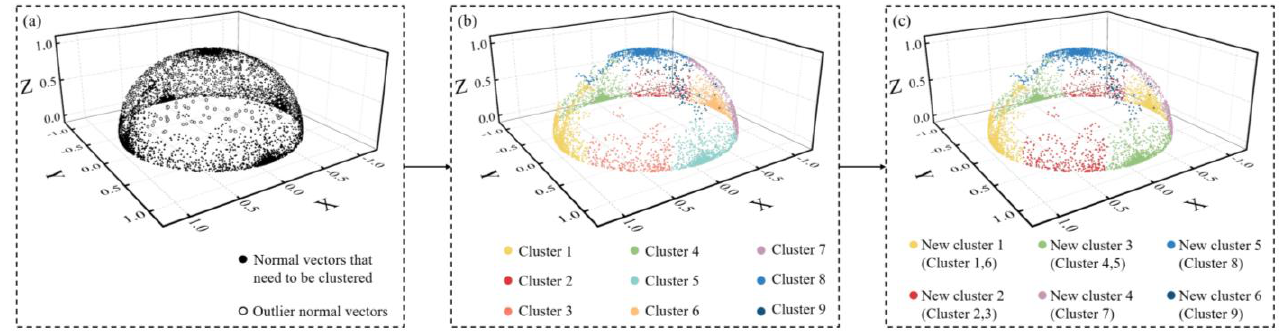
Figure 3. The K-means-clustering process on the Gaussian half-sphere: ( a ) deleted outliers denoted as the hollow symbols; ( b ) original K-means-clustering results; and ( c ) clustering results after adjustments.